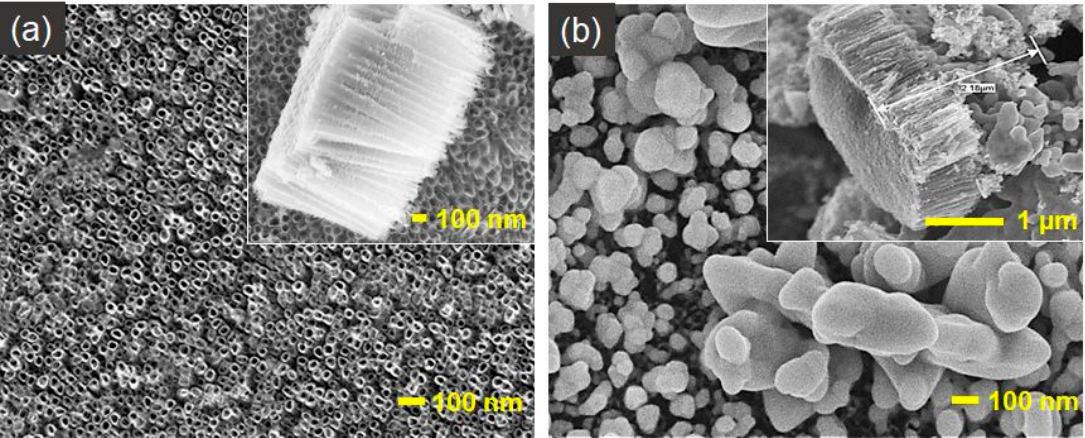
Figure 1. SEM top-view and cross-sectional (on insets) images of: ( a ) TNT and ( b ) Ag / TNT Figure 1. SEM top - view and cross-sectional (on insets) images of: ( a ) TNT and ( b ) Ag/TNT reference reference electrodes.